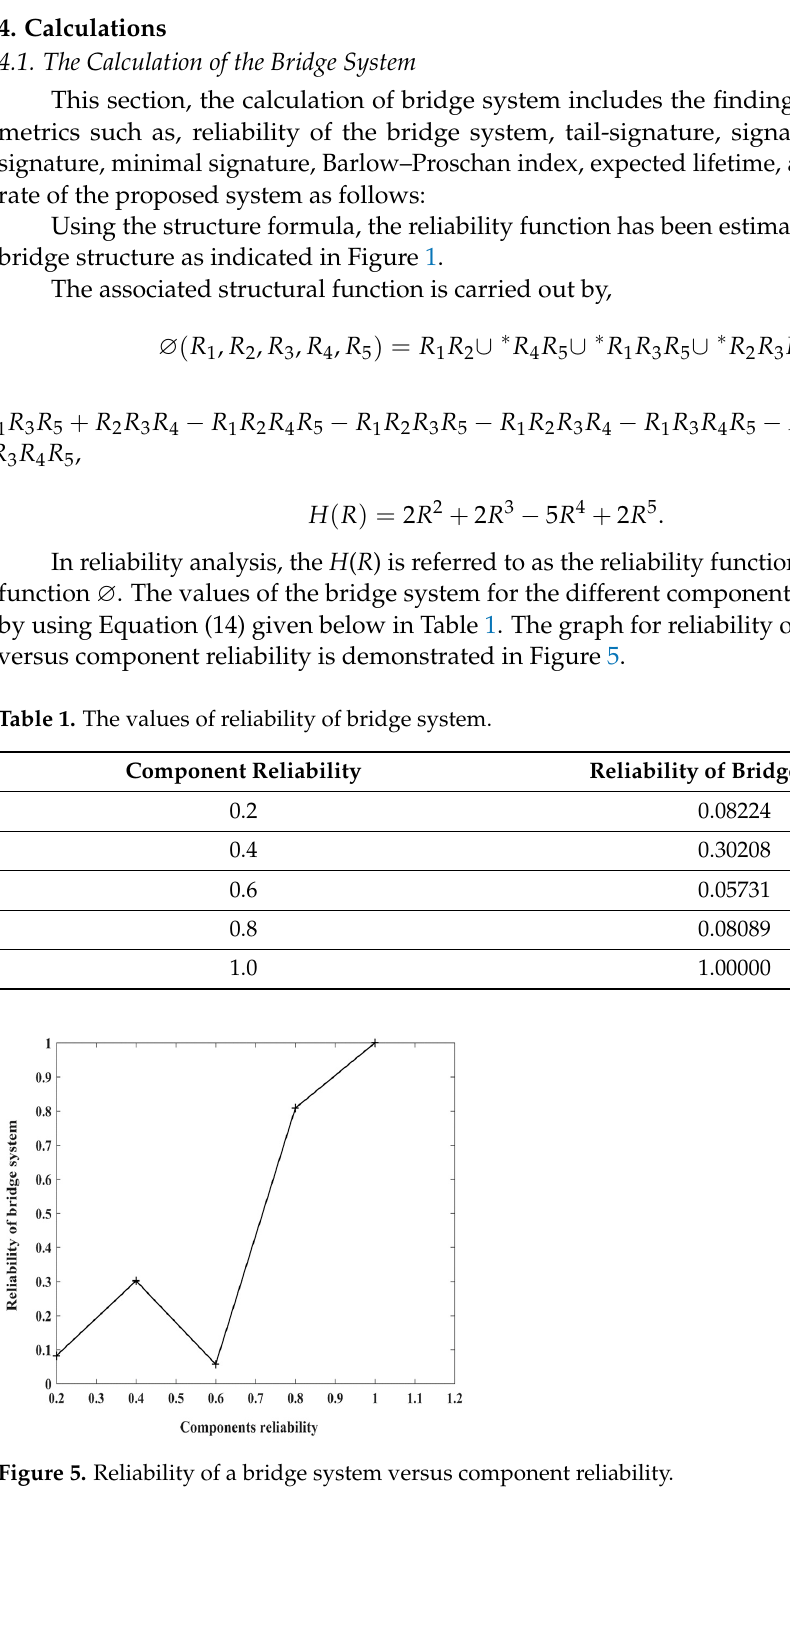
Figure 4. Block diagram of three serially connected systems.